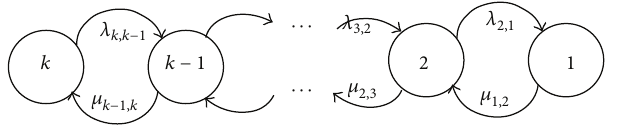
Figure 1: The state-space diagram of repairable multistate element with minor failures and minor repairs.